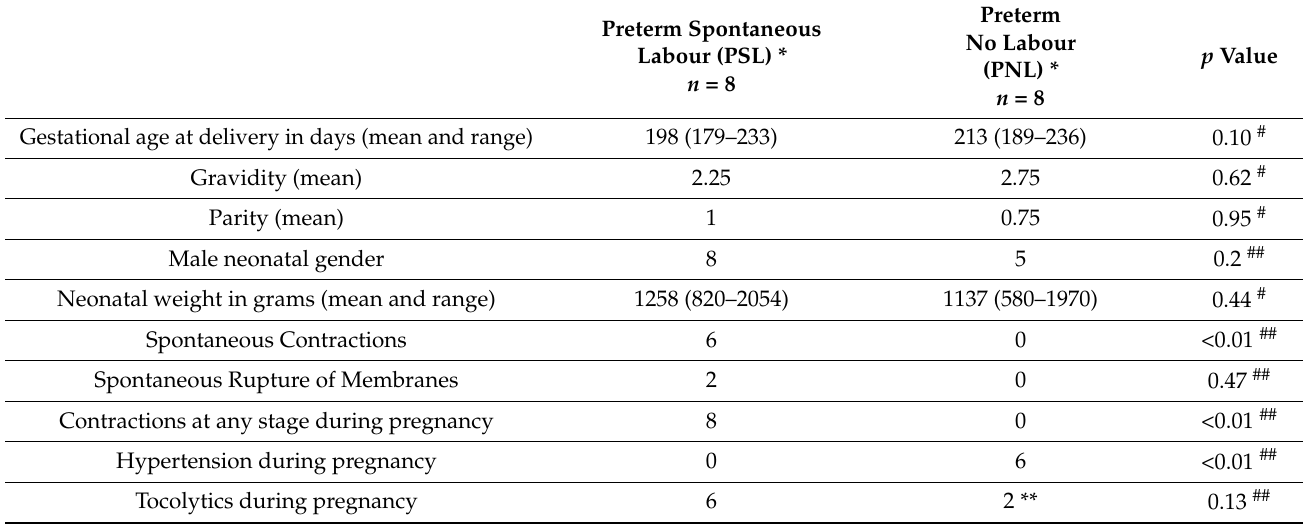
Table 3. Clinical characteristics of patient samples used for microarray analysis.